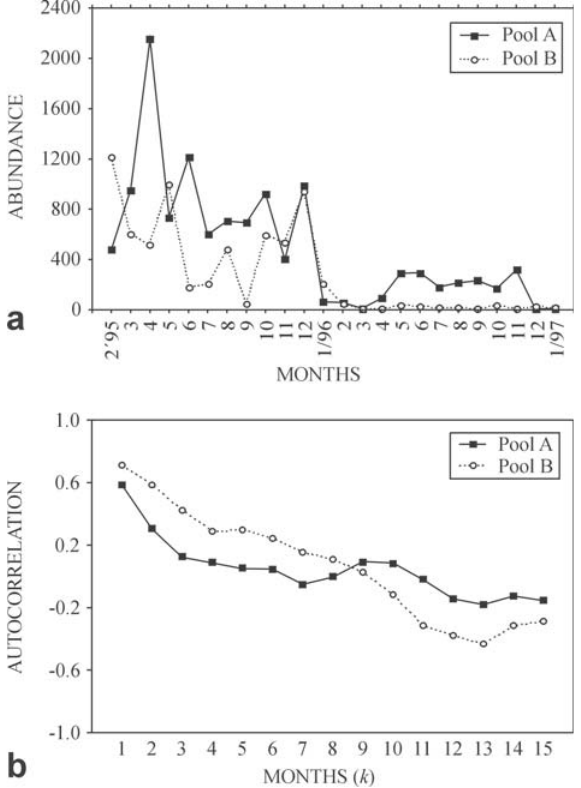
Fig. 6. Temporal variability (a) and correlogram of total abun- dance (b) of small-sized fish recorded in the experimental fish ladder (Pool A = 10 m, Pool B = 27 m) located near Itaipu